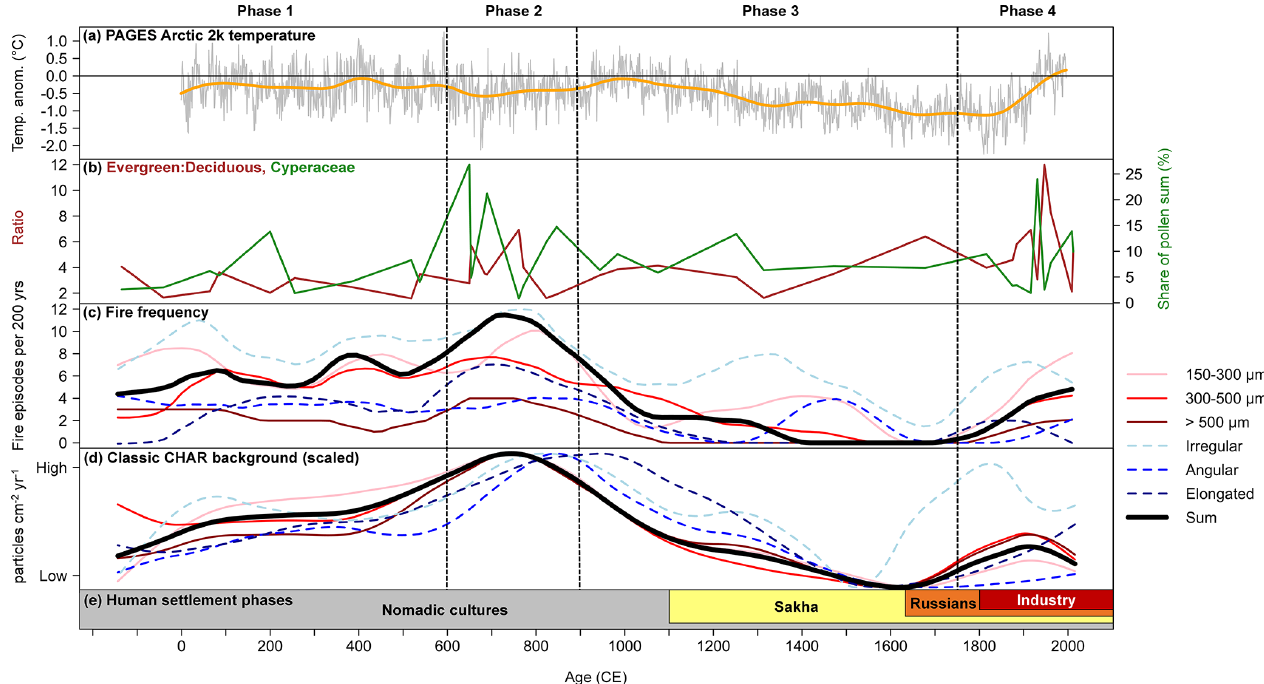
Figure 6. Comparison of the charcoal record with climate, vegetation, and general human settlement phases. Vertical dashed lines mark the different phases of the fire regime. (a) PAGES Arctic 2k temperature (grey curve = original annual data; yellow line = LOESS). (b) Selected vegetation proxies. (c) Fire frequency: compiled, smoothed frequencies of fire episodes for the sum of particles and individual size classes and morphotypes. (d) Compiled classic CHAR background components for the sum of particles and individual size classes and morphotypes, scaled to equal extents for comparison. (e) General human settlement phases, referenced in the text. For (c) – (d) , lines represent size and morphotype classes, as well as the sum of charcoal